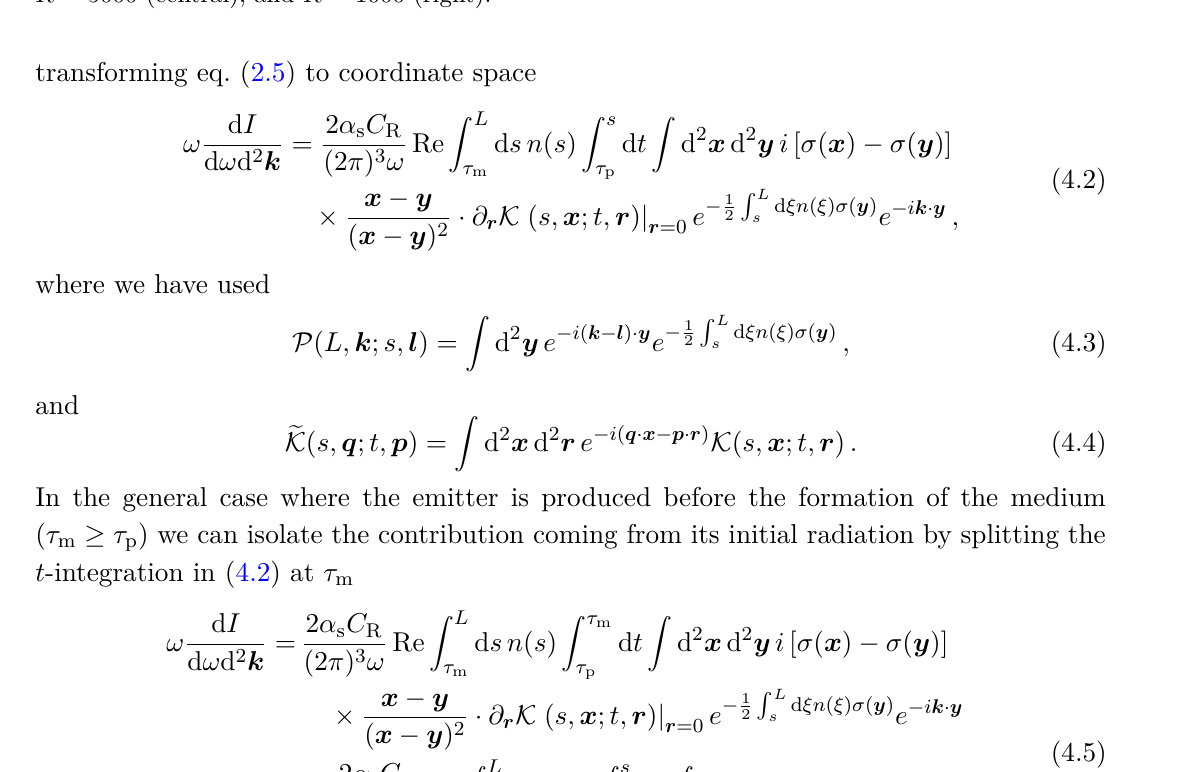
Figure 5 . GLV medium-induced energy spectrum for the three scenarios: τ p = τ m = 0 (green solid lines); τ p = τ m = 0 . 3 L (blue dashed lines); and τ p = 0 and τ m = 0 . 3 L (red dash-dotted lines) as function of ω/ ¯ ω c for n 0 L = 5 . The different panels correspond to different sets of ¯ R : ¯ R → ∞ (left), ¯ R = 5000 (central), and ¯ R = 1000